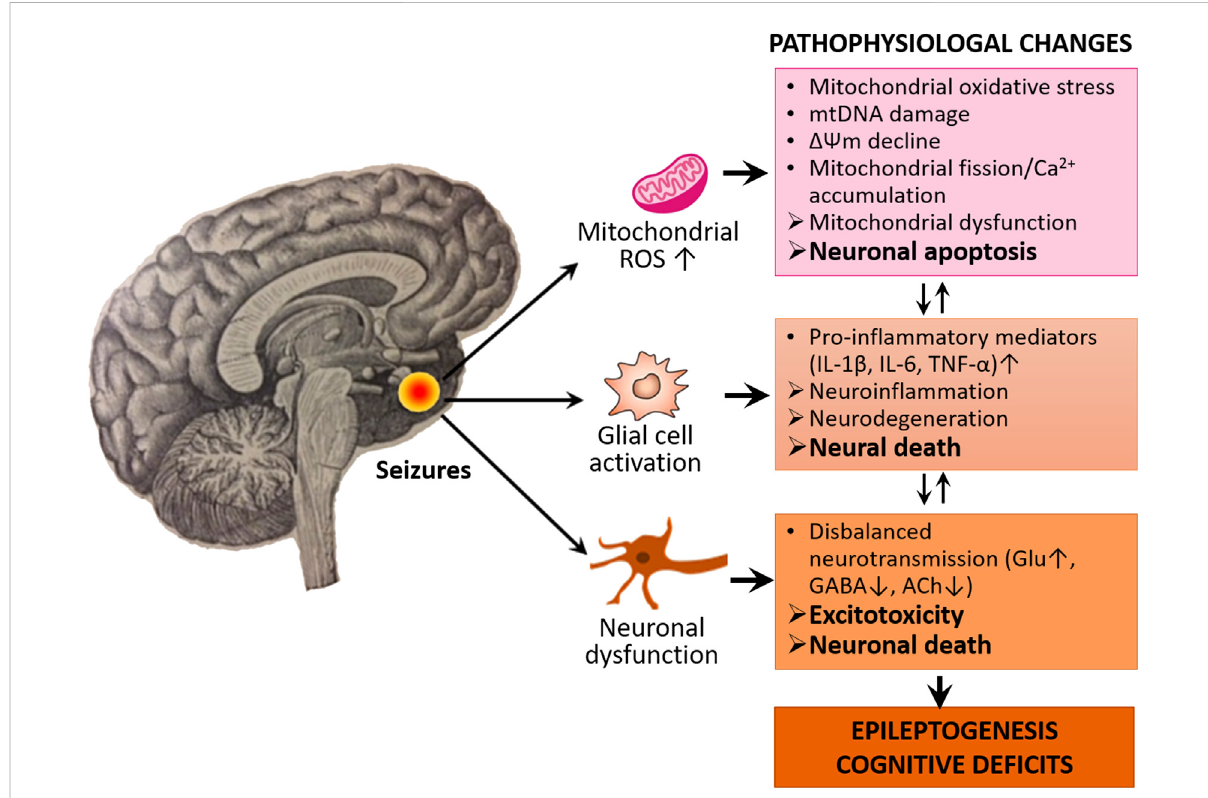
FIGURE 1 Oxidative stress, neuroin fl ammation, and excitotoxicity characterize the epileptogenic process and cognitive de fi cits. The activated neuroglia (microglia and astrocytes) releases pro-in fl ammatory mediators such as cytokines including IL-1 β , IL-6, and TNF- α , thereby leading to neuroin fl ammation and neurodegeneration. In oxidative stress conditions, the mitochondria increase ROS production which causes mitochondrial oxidative stress, damage and dysfunction, thereby leading to neuronal apoptosis. Seizures also cause disturbance of neurotransmission